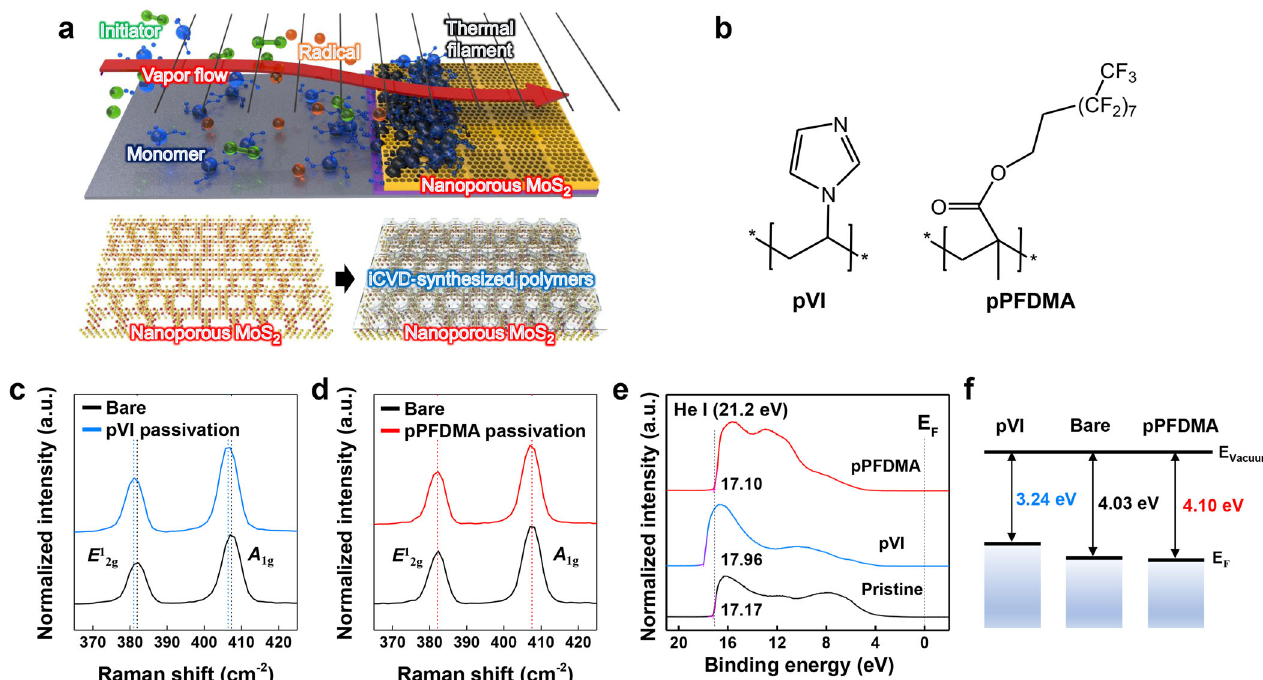
Fig. 2 Polymeric passivation of nanoporous MoS 2 fi lms using pVI and pPFDMA, respectively. a Schematic illustration of the passivation of nanoporous MoS 2 by iCVD process and b chemical structures of passivation layers. c , d Raman spectra and e UPS spectra of the pVI- and pPFDMA-passivated nanoporous